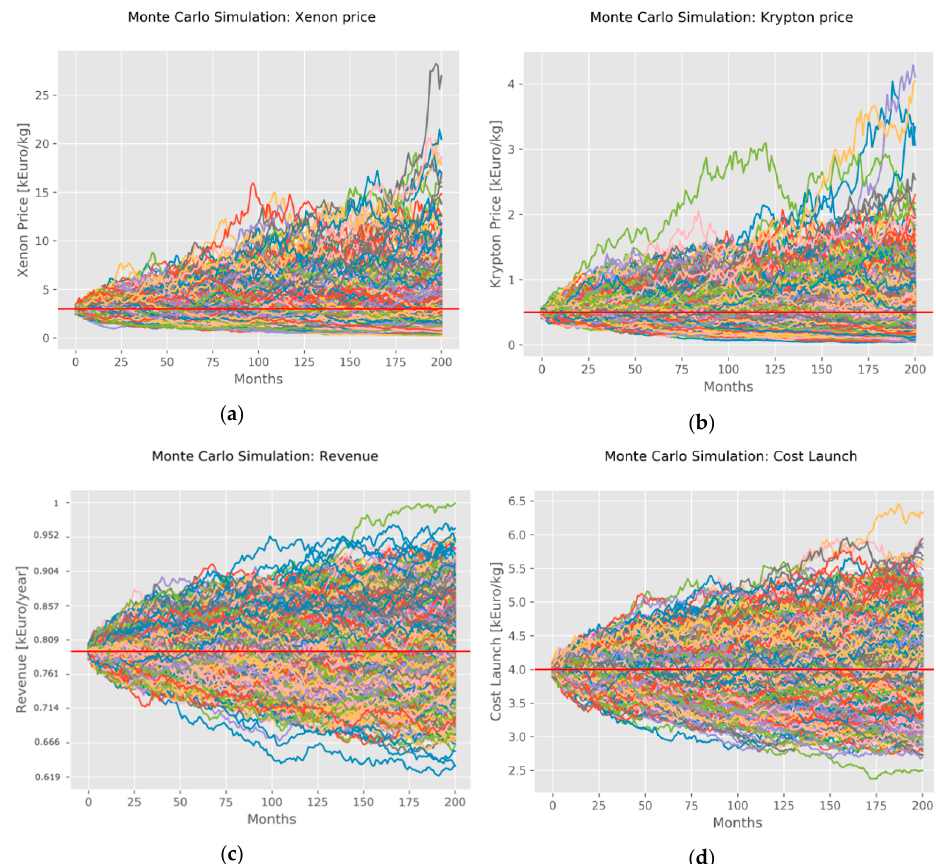
Figure 7. 1000 scenario variations of market input data based on the Wiener stochastic model: ( a ) xenon price; ( b ) krypton price; ( c ) revenue per year; ( d ) cost launch per kg. The data regarding the revenue per year ( c ) are normalized to preserve company sensitive information. Each color line represents a single scenario (1000 scenario variations in total).